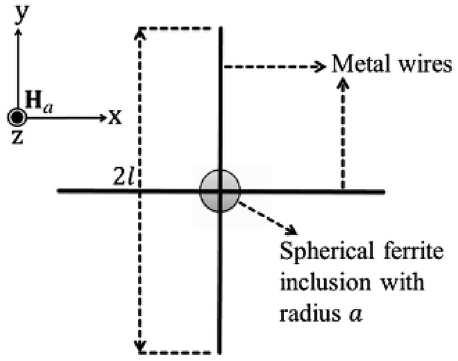
Figure 7: Tellegen – Omega nonreciprocal magnetoelectric particle (reprinted with permission from Ref.